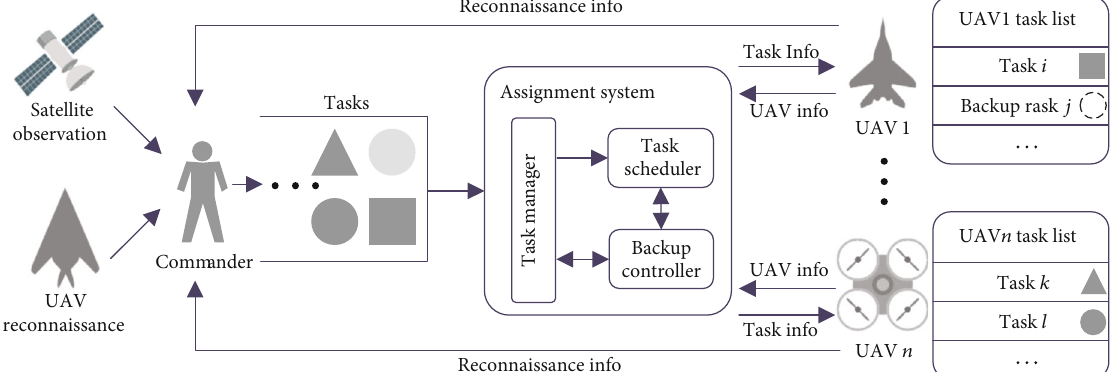
Figure 2: Task assignment